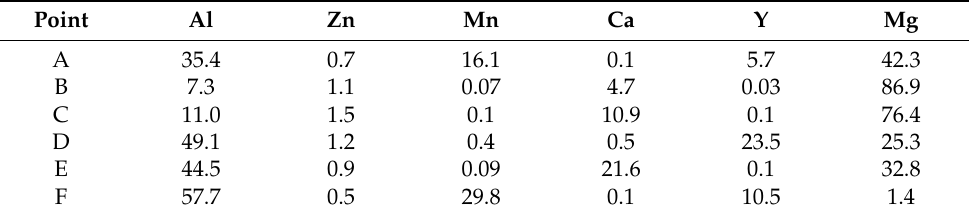
Table 1. Chemical composition (in at.%) of the second phases in the annealed AZXW1000, 2000, and 3000 sheets indicated by yellow arrows in Figure 5, analyzed by SEM-EDS.